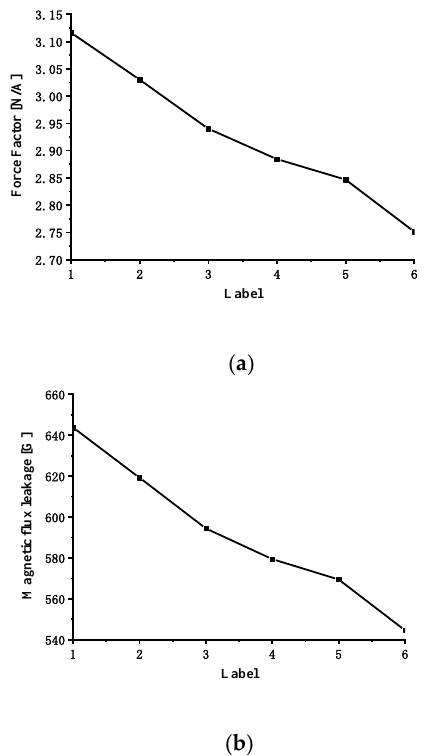
Figure 7. Analysis results with changing magnet grade: ( a ) force factor; ( b ) flux leakage.